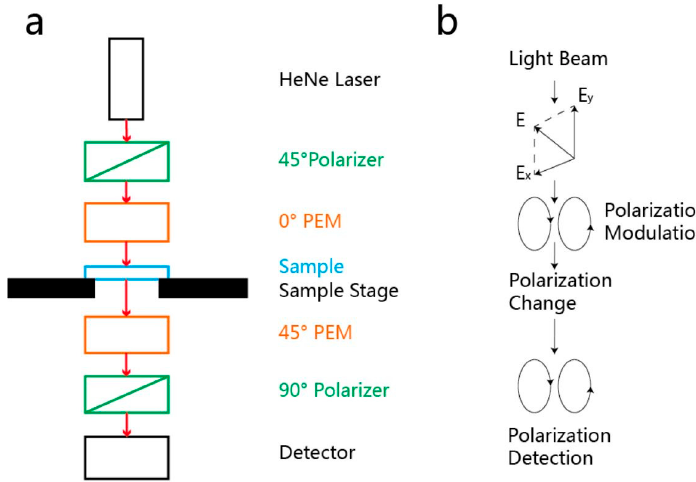
Figure 3. Optical system of Exicor 300AT for birefringence measurement ( a ) and light polarization in each step ( b ) .